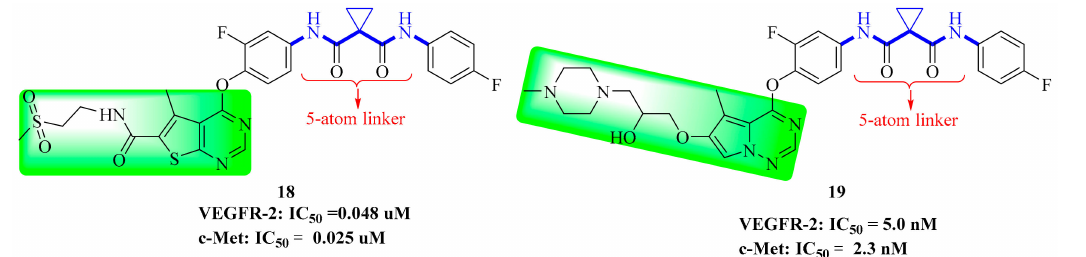
Figure 10. Thienopyrimidine and pyrrolotriazine derivatives of dual VEGFR / c-Met